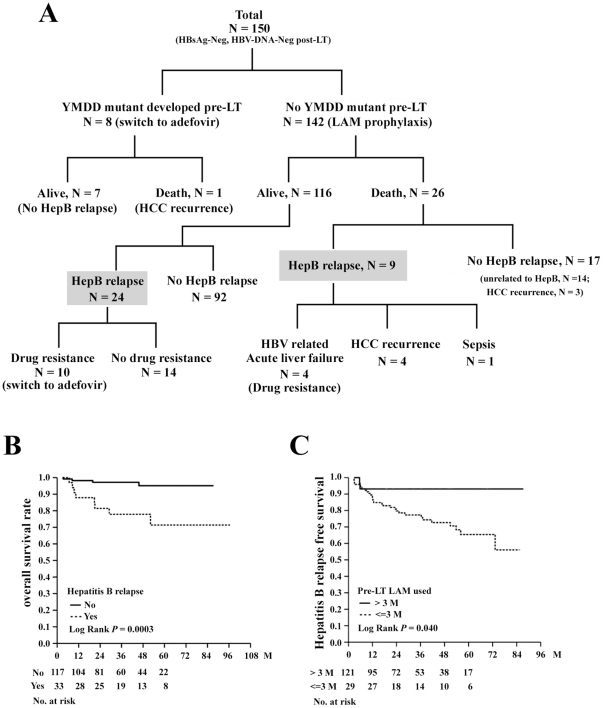
Clinical outcomes of the patients included and clinical factors related to OS or hepatitis B relapse free survival.(A) Clinical outcomes of 150 patients receiving LT. Hepatitis B (HepB) relapse did not occur in 8 patients who developed YMDD mutants and were switched to adefovir therapy before LT (left branch), whereas HepB relapse occurred in the remaining 142 patients who did not develop YMDD mutants. The clinical consequences of these patients were illustrated. The 33 patients with hepatitis B relapse were marked by a shaded background. (B) Comparison of OS between patients with (dashed line) and without (solid line) hepatitis B relapses. (C) Comparison of hepatitis B relapse free survival between patients receiving longer (>3 months; solid line) and shorter (≤3 months; dashed line) durations of pre-LT LAM treatment.